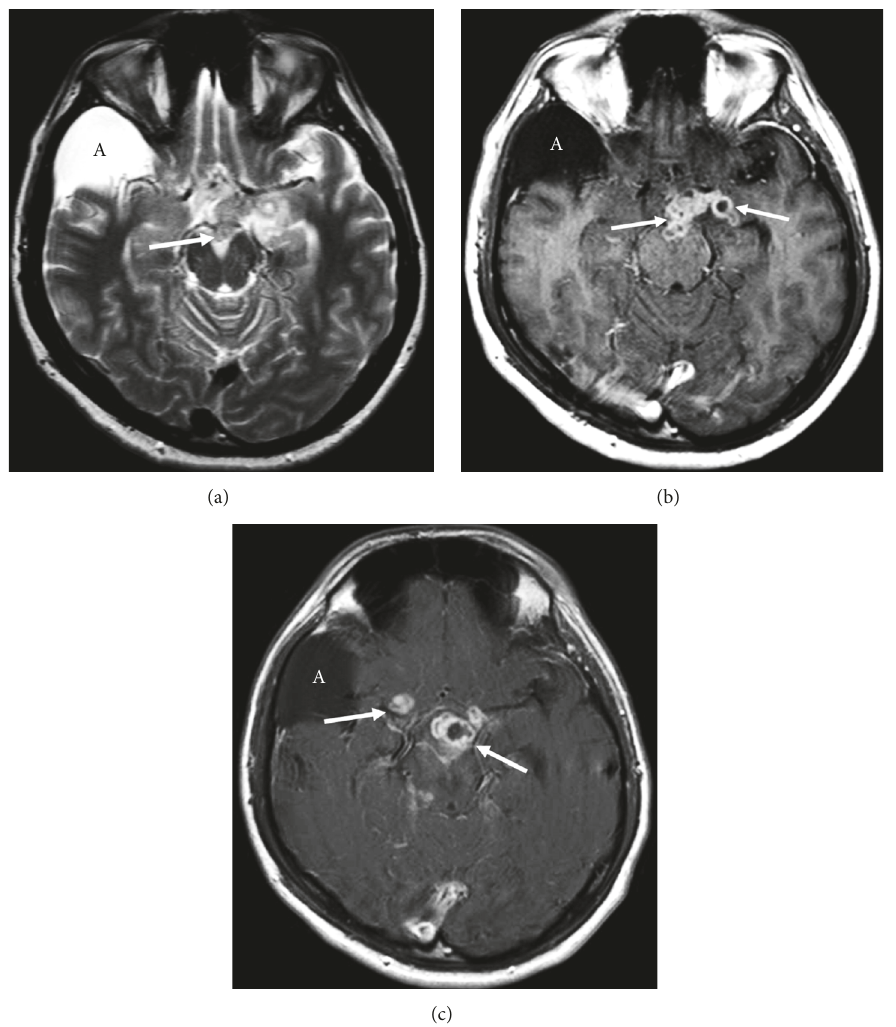
Figure 2: Axial FSE T2 (a) and postcontrast T1 (b and c) images at about 2 weeks of admission. T2 hypointense (a) nodular basal leptomeningeal lesions (arrows) with rim enhancement (b and c). Incidental arachnoid cyst